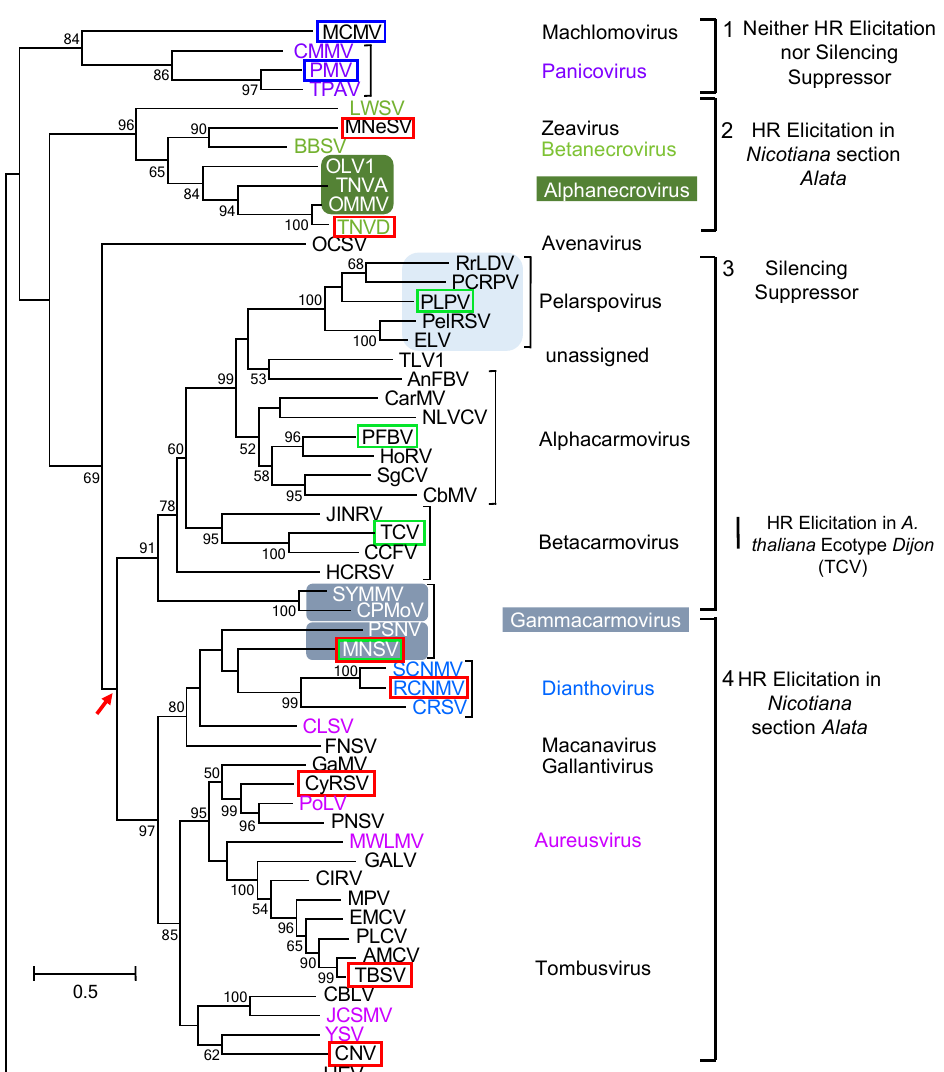
Figure 4. Phylogenetic (distance) analysis of 54 CPs of CP-encoding tombusvirids. ML trees were generated as described in materials and methods. There were 356 positions in the final dataset. Hepatitis E virus (HEV) CP (AAA03191.1) was used as the outgroup. Brackets and / or colored text and / or